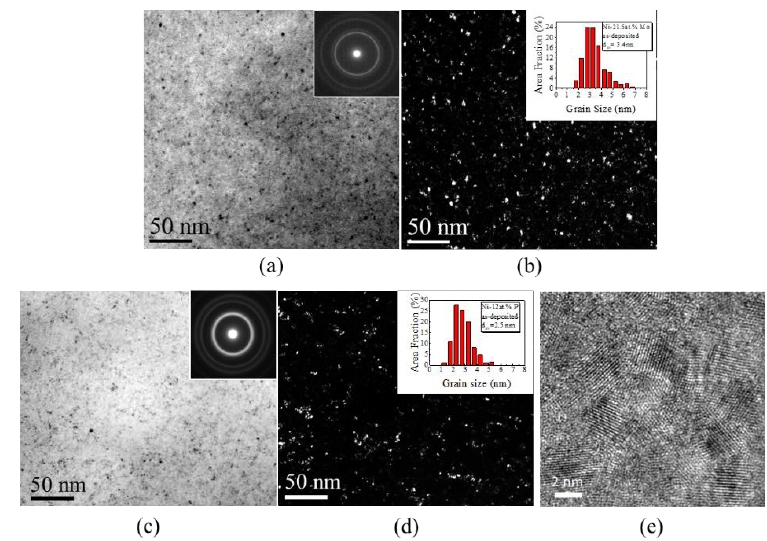
Figure 3. Typical ( a , c ) bright field (BF) and( b , d ) dark field (DF) images of electrodeposited ( a , b ) ng Ni-21.5 at.% Mo and ( c , d ) Ni-12 at.% P. The insets of ( a , c ) and ( b , d ) are the corresponding selected area electron diffraction (SAED) patterns and grain size distributions, respectively. ( e ) A typical high resolution transmission electron microscope (HRTEM) image showing some tiny grains in ng Ni-12 at.% P.